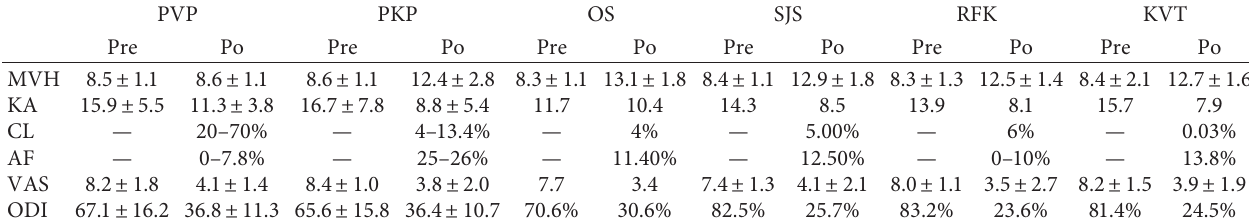
Table 1: The outcome comparison of different vertebral augmentation techniques.